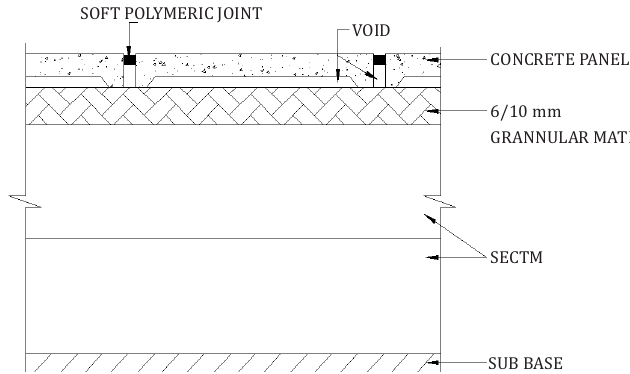
Figure 8. Joint in Nantes,